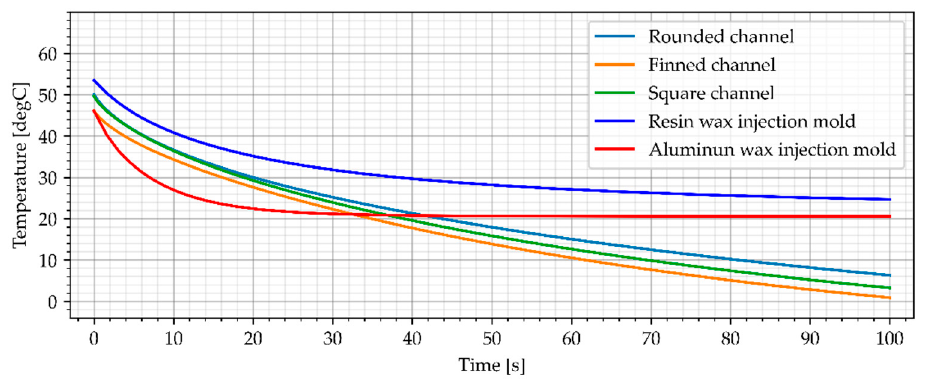
Figure 20. The sample temperature for air cooled wax injection molds (middle point).